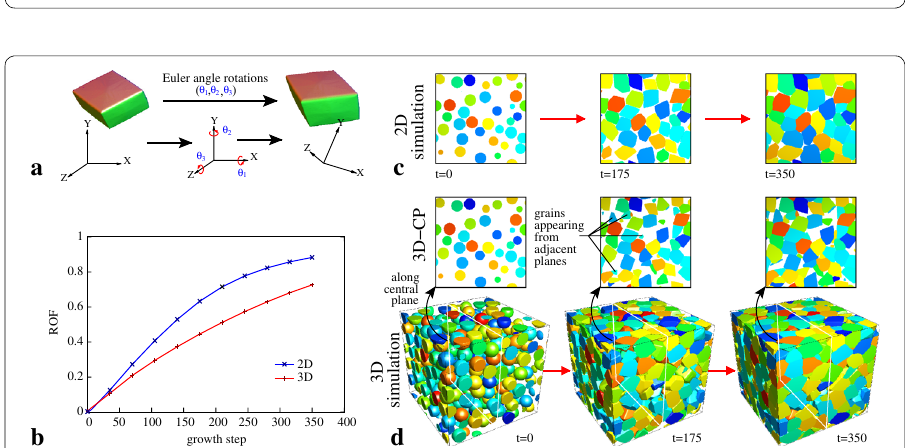
Fig. 3 a Schematics illustrating the Euler angle rotations of a calcite crystal used for assigning randomly oriented grain distribution in 3D. b Plots of relative overgrowth fraction (ROF) with growth step for the grain growth simulations in 2D and 3D. The dynamic behavior implies that overgrowth kinetics is faster in 2D as compared to 3D. c Simulated 2D calcite overgrowth (in rgb colors ). Colorless white region in the domain denotes liquid. d Simulated 3D calcite cementation. The outlet pictures show the evolution of grains along the central plane of the 3D simulation. Appearance of additional grains from the adjacent planes is observed, which significantly influences the dynamics of